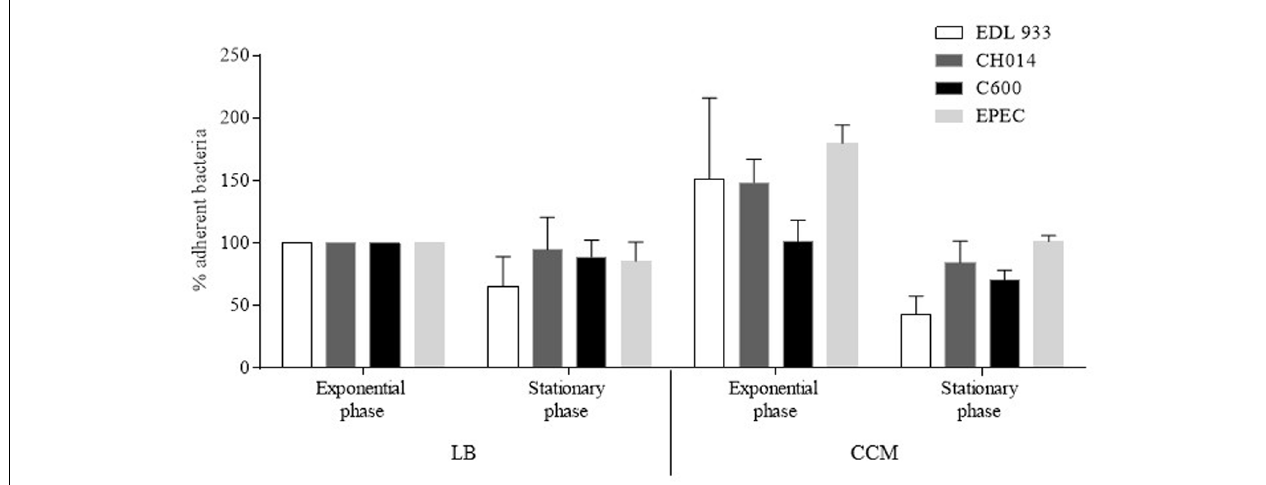
diluted and plated for colony forming unit counting. Results are expressed as percentage of adherent bacteria, relative to adherent bacteria obtained after a 3 h growth in LB taken as 100%. EDL933: EHEC O157:H7; CH014: non-O157 STEC; C600: K-12 E. coli ; E2348/69: EPEC. All assays were performed independently at least three times. Results are means ± SEM of bacteria adhering toT84